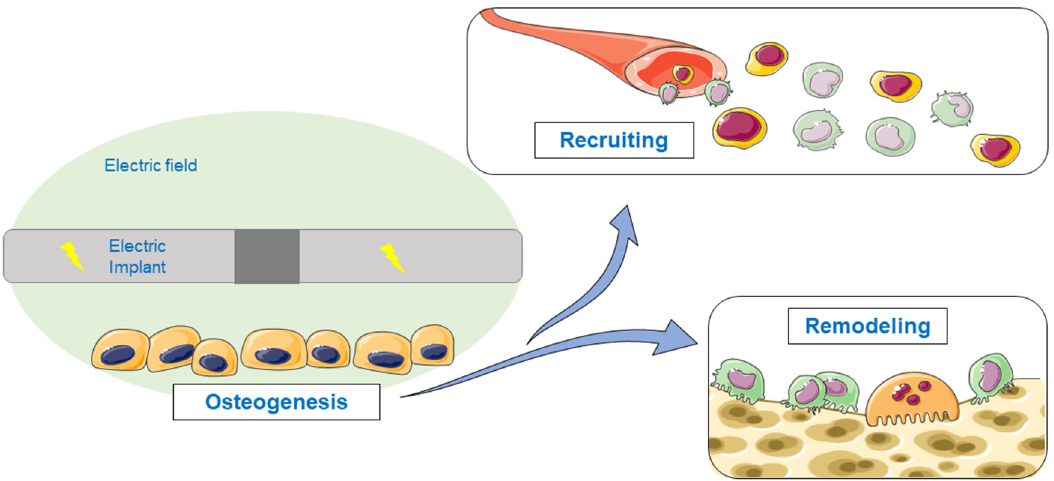
Figure 1. Schematic overview of the study aim. Stimulated osteoblasts produce signaling molecules that influence osteoclastogenesis through recruiting and remodeling processes. Single pictures were used from Servier Medical Art (http://smart.servier.com/, accessed on 14 June 2022).